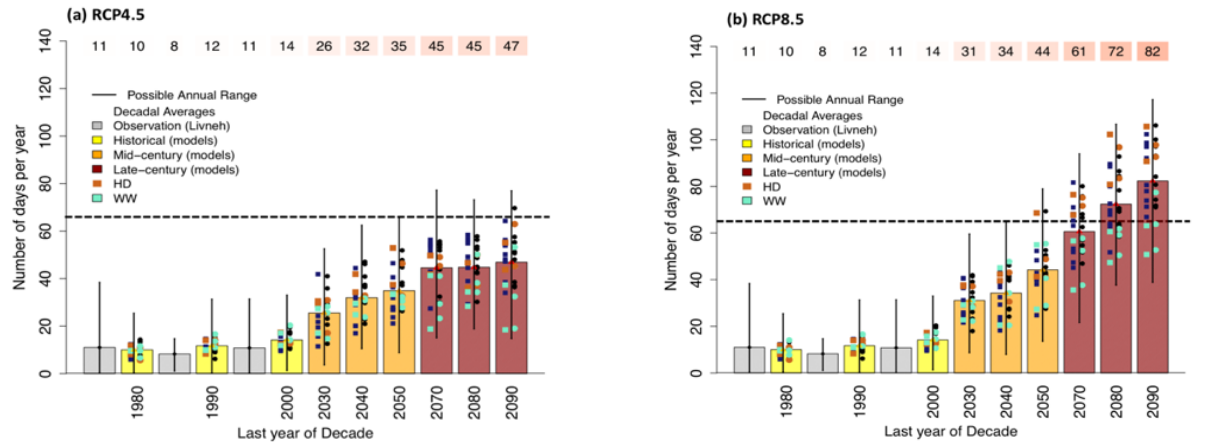
Figure 4. Bar plot of decadal multi-model average climate model projections of the number of extreme heat (100 °F) days for ( a ) RCP4.5 and ( b ) RCP8.5. Different shading denotes observations, and the three reference periods. Range bars (thin vertical lines) depict the 5th – 95th percentile of the spread of frequencies from each model/observation. Each marker denotes specific model projections for MACA (right, circles) and LOCA (left, squares) with HD and WW models shaded separately. The text values above each sub-panel show the multi-model mean number of extreme heat days for both SD methods, and the horizontal black line denotes the number of days observed in Oklahoma City during the 2011 heatwave and drought.